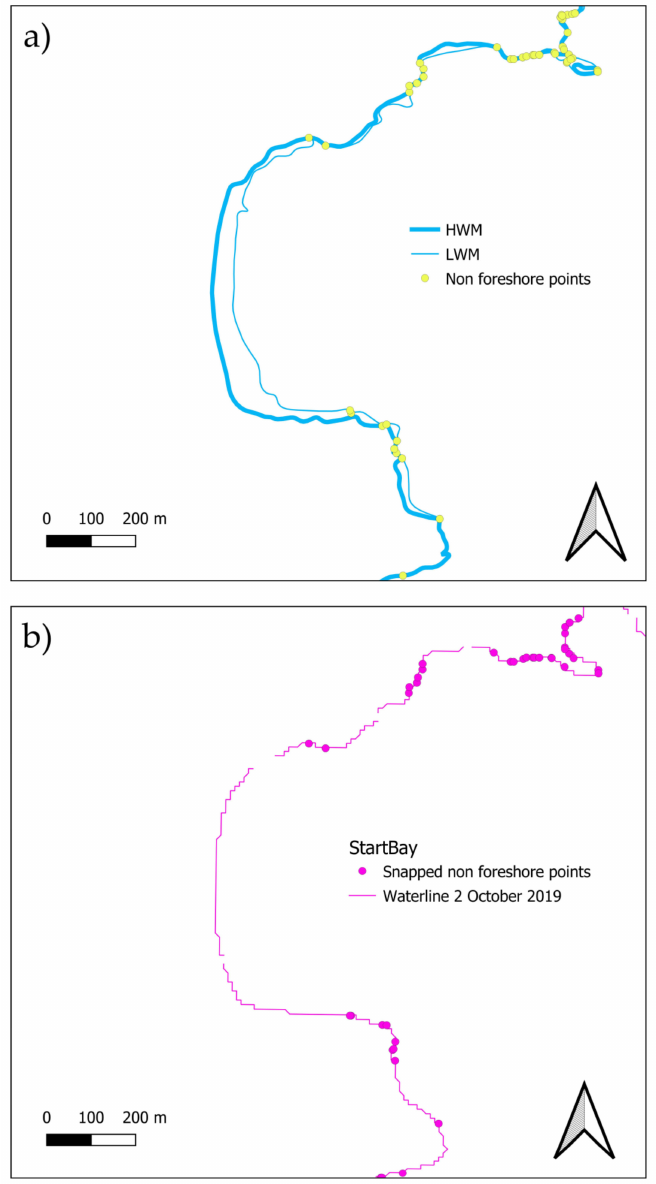
Figure 4. Illustration of the non-foreshore method used to assess absolute and relative accuracy of shorelines and waterlines; ( a ) non-foreshore locations have been extracted (yellow circles) as the locations where the HWM and LWM tidal boundaries of OS VectorMap District lines intersect; ( b ) the non foreshore points are snapped (magenta dots) to the waterline (magenta line), for this example from S2 with date 2 October 2019. The absolute accuracy is measured as the distance between the yellow circles and the closest snapped points (magenta circles). The relative accuracy is measured as the difference of the distances between yellow points and the distances between the matching magenta points. Contains Ordnance Survey data © Crown copyright and database right 2022. Ordnance Survey Licence no.